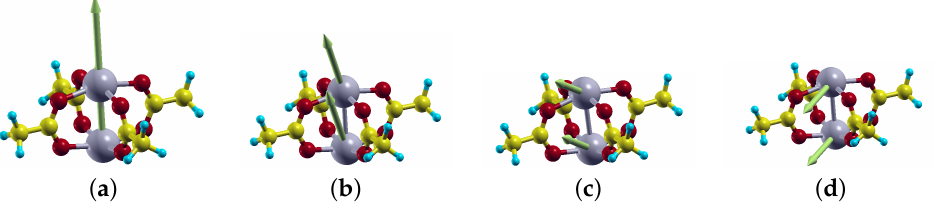
Figure 2. The magnetization of Mo atoms for some of the considered polar angles: θ = 0 ◦ ( a ); θ = 30 ◦ ( b ); θ = 60 ◦ ( c ); θ = 90 ◦ ( d ). The Mo-Mo EMA is defined by the direction of magnetizaion in ( a